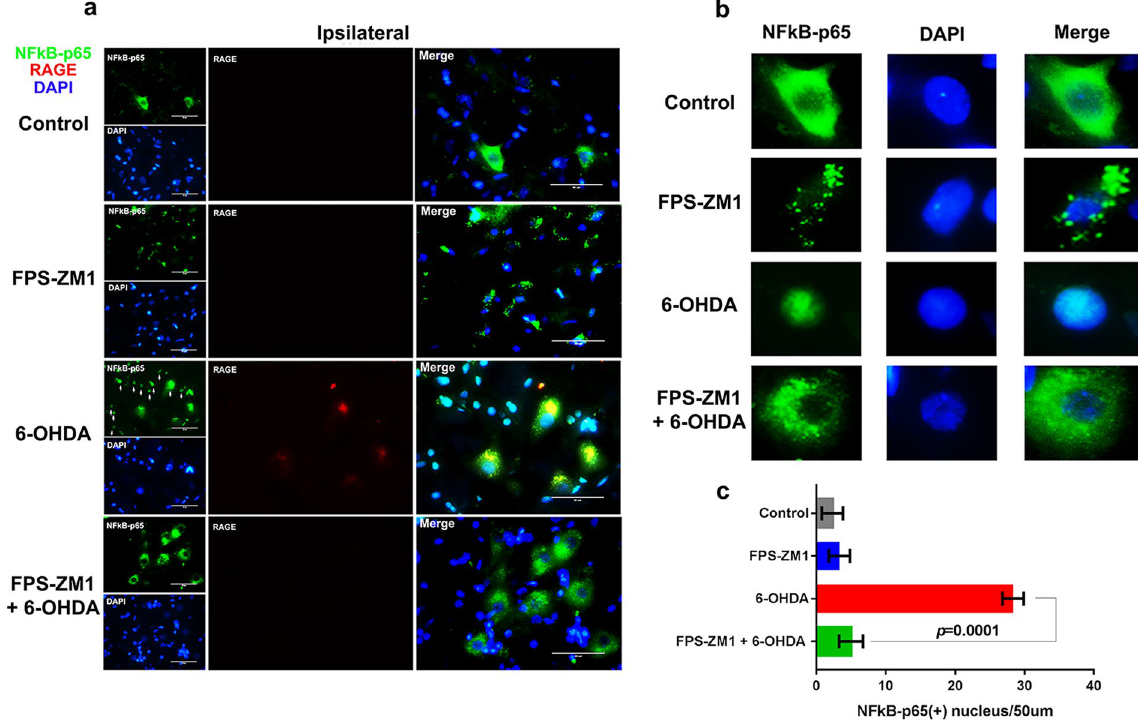
Figure 3. FPS-ZM1 blocked the 6-OHDA-induced nuclear translocation of NF- κ B-p65. Rats were prepared for immunofluorescence 15 days after 6-OHDA administration. ( a ) Representative co-immunofluorescence images of SN immunostained for NF- κ B-p65, RAGE and DAPI ( n = 10 per group). The ipsilateral sides are showed. The microscopy images were taken with 50 μ m of magnification. ( b ) Cell details. ( c ) p65 + nucleus quantification/ picture with 50 μ m magnification area. Values represent mean ± SD from 6 rats per group. One-way analysis of variance and Bonferroni Multiple Comparison post-hoc test were applied to all data. p values are embedded in the